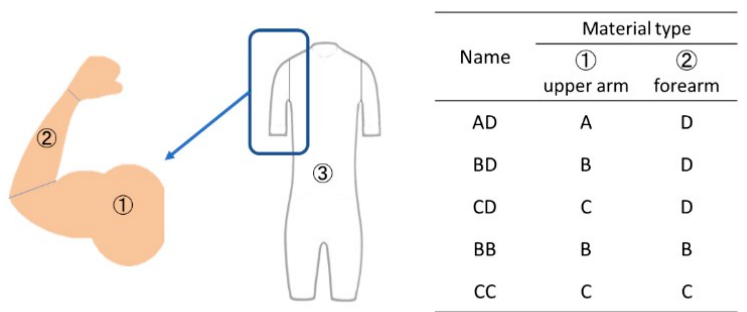
Figure 10. Combinations of cycling suit fabrics used in this experiment. We separated the arms into upper arms and forearms and used five types of suits, made with combinations of four different types of fabric (A to D). The body part ③ of all the five suits was made with fabric D.